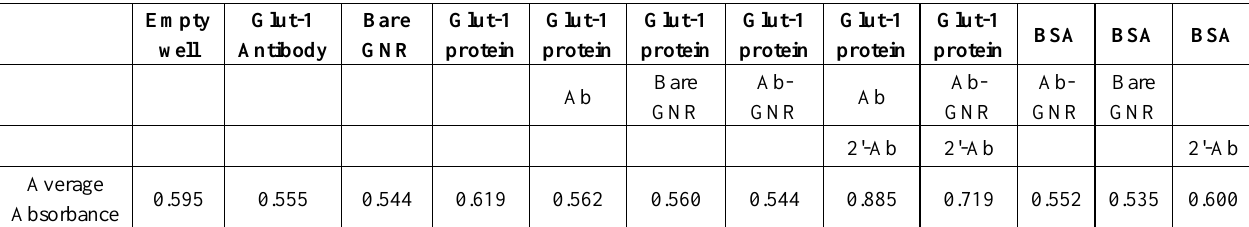
Table 2. Average optical absorbance measured using plate reader with a 750 nm emission filter for each